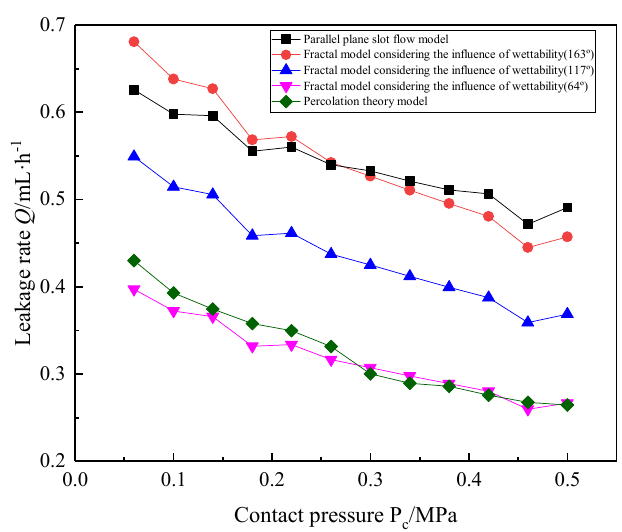
Figure 9. Comparison of leakage rate calculation between different models.